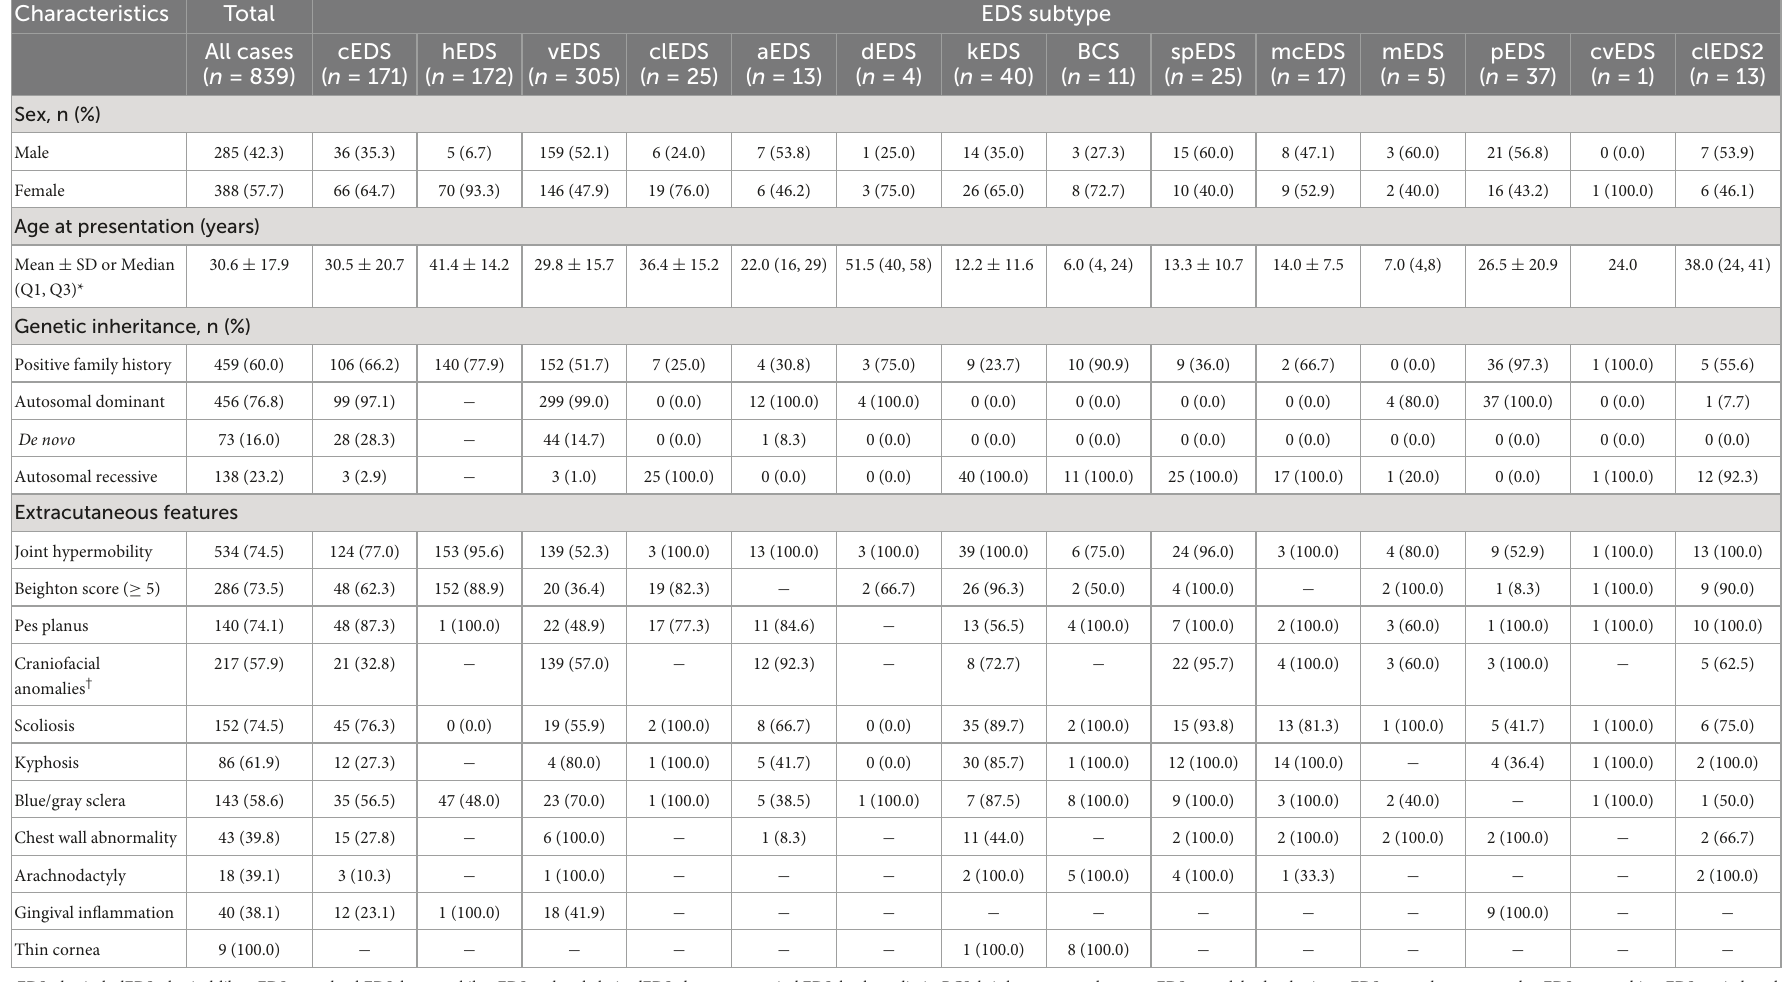
TABLE 1 Demographics, inheritance, and extracutaneous features of patients with Ehlers-Danlos